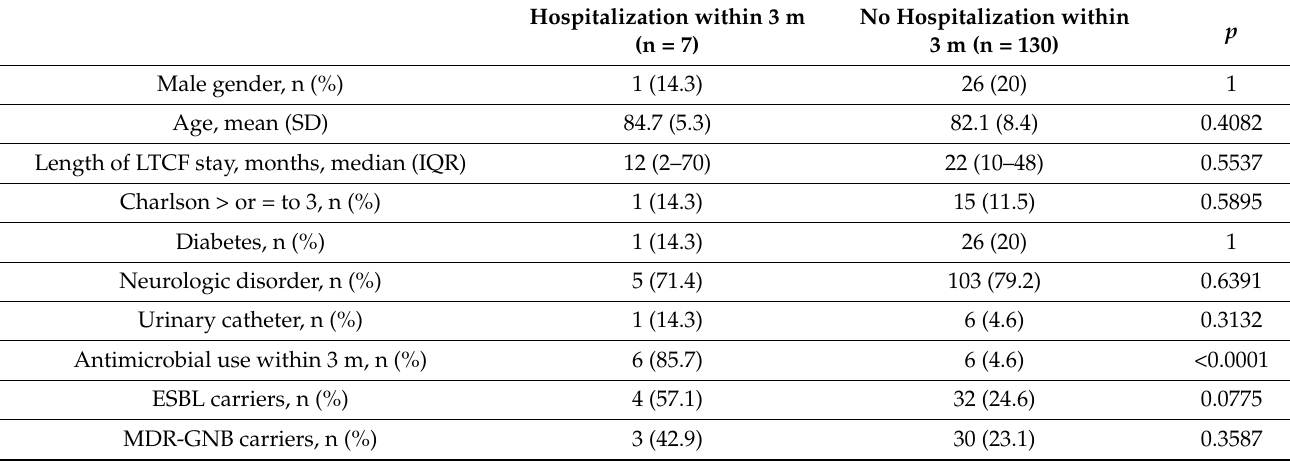
Table 2. Characteristics of LTCF residents regarding hospitalization within the last 3